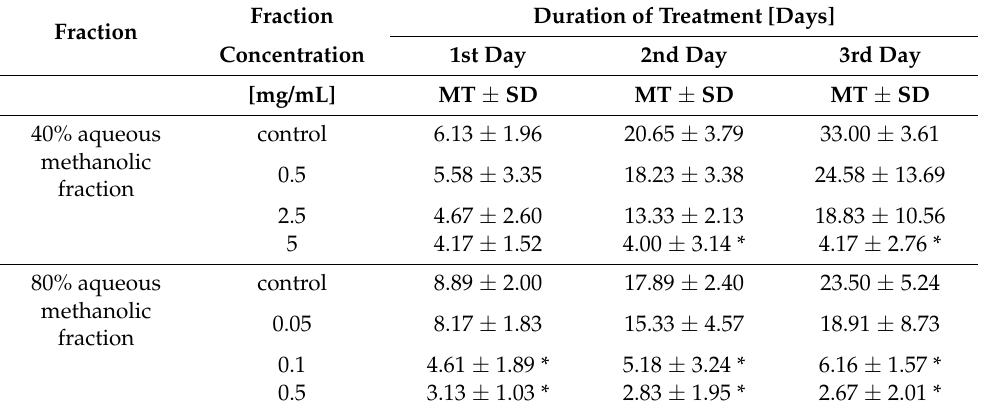
micropropagated Lychnis flos-cuculi at different concentrations on Acanthamoeba trophozoite inhibition during three-day treatment. Figure 2. The effect of unfractionated 80% aqueous methanolic extracts from the herb and roots of Lychnis flos-cuculi on the inhibition of Acanthamoeba trophozoite proliferation in the culture medi- um.